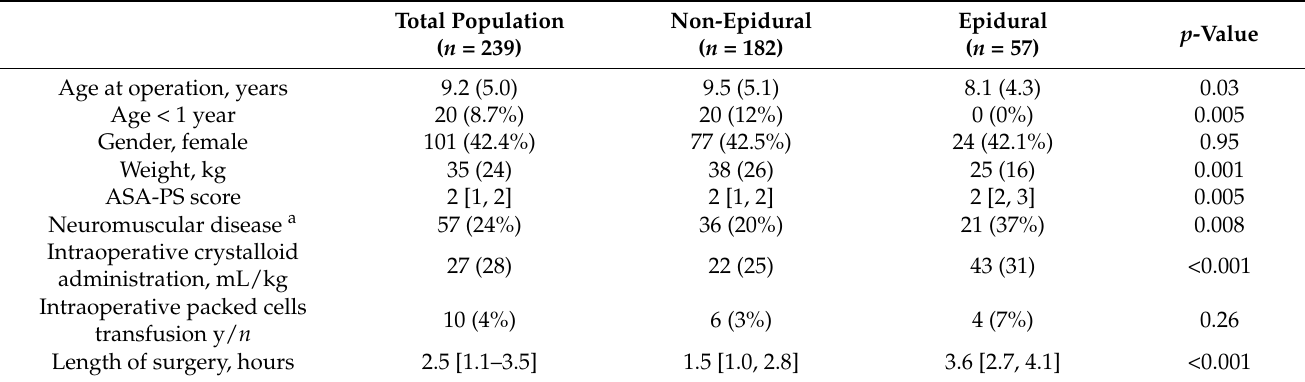
Table 1. Characteristics of children undergoing orthopedic surgery of hips or lower extremities with and without epidural analgesia. Total Population Non-Epidural ( n = 239) ( n =